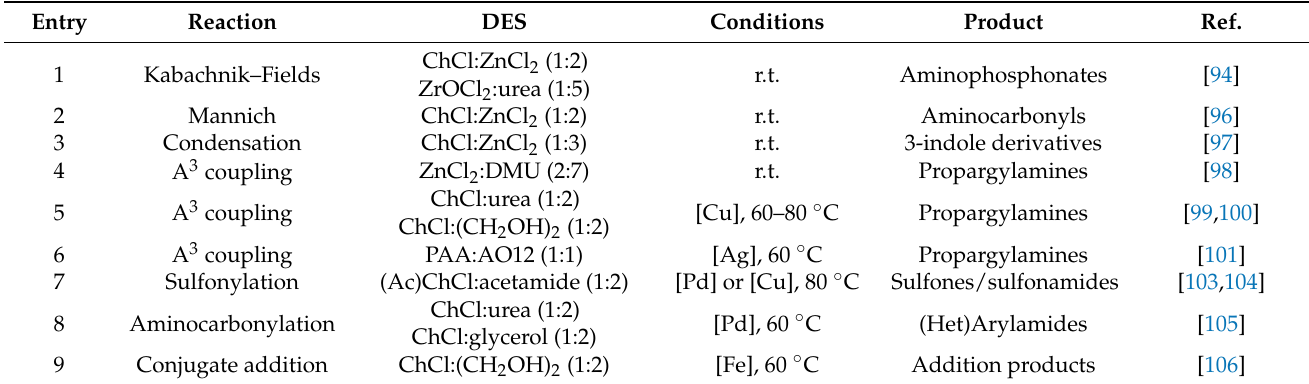
Table 5. Selected examples of MCR catalyzed by transition metals in DESs.